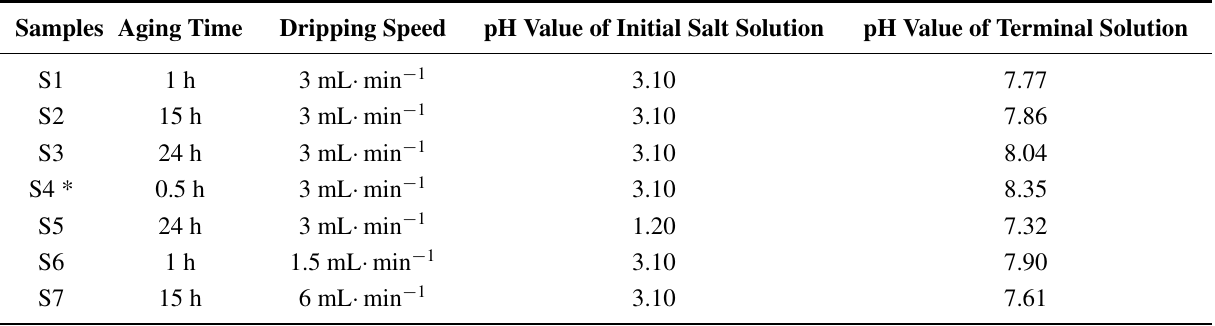
Table 1. Titration condition of different samples.